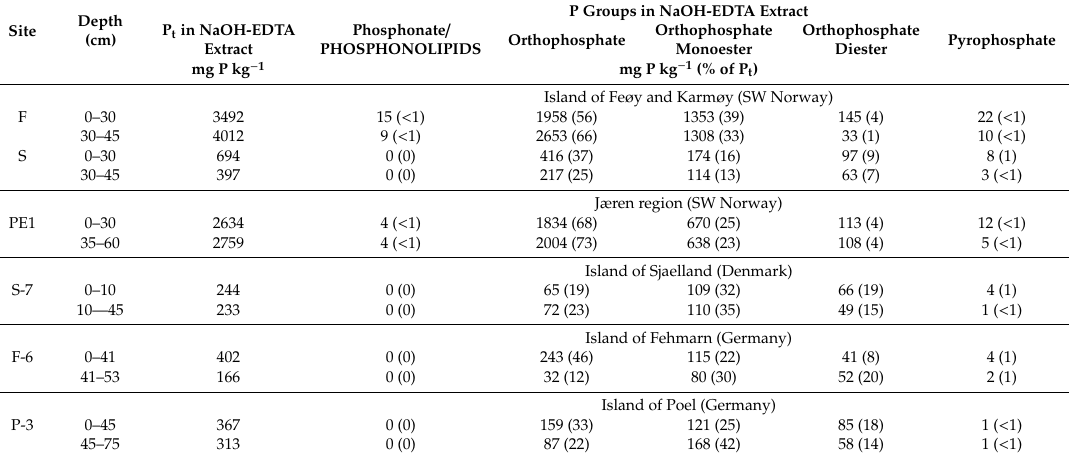
Table 4. Concentrations of total P (mg kg − 1 ) in the NaOH-EDTA extract and the concentrations of organic and inorganic phosphorus compounds determined in the NaOH-EDTA extracts of soil samples by solution 31 P NMR spectroscopy. Values in parenthesis show the proportions of the P species of P t of